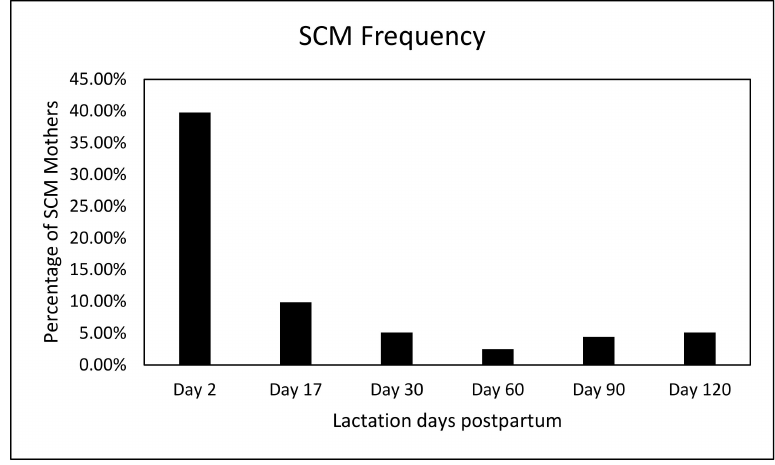
Figure 2. Frequency of SCM in a European cohort of lactating mothers across four months of